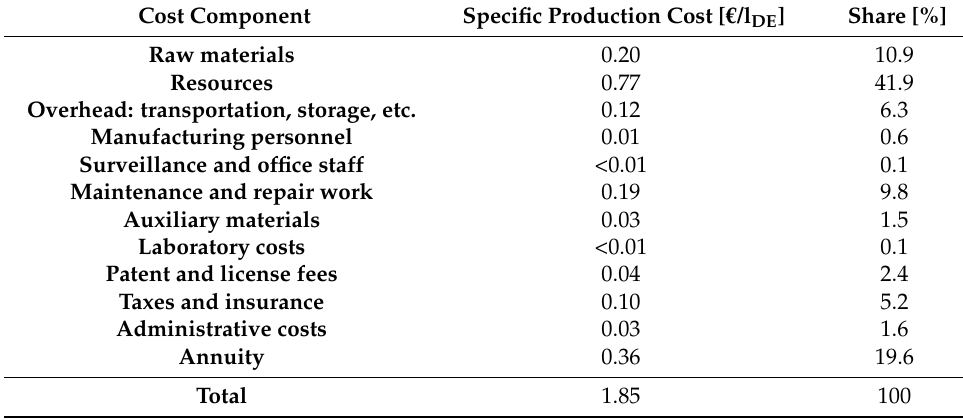
Table 7. Distribution of the fuel production costs according to Otto [81].